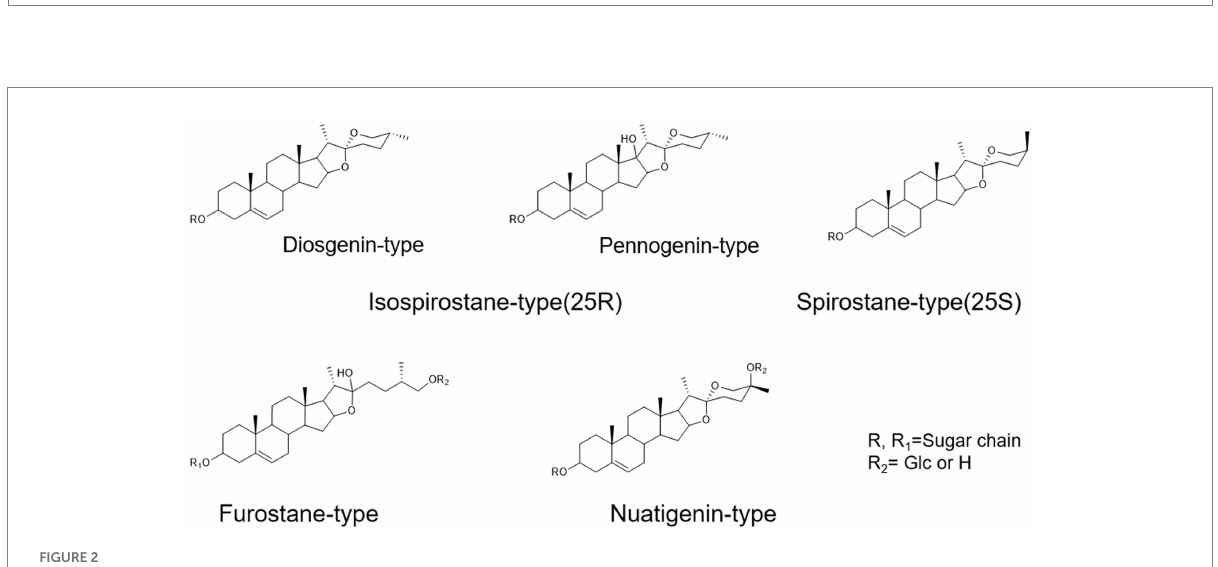
FIGURE 2 The main configuration of steroidal saponins in Paris polyphylla